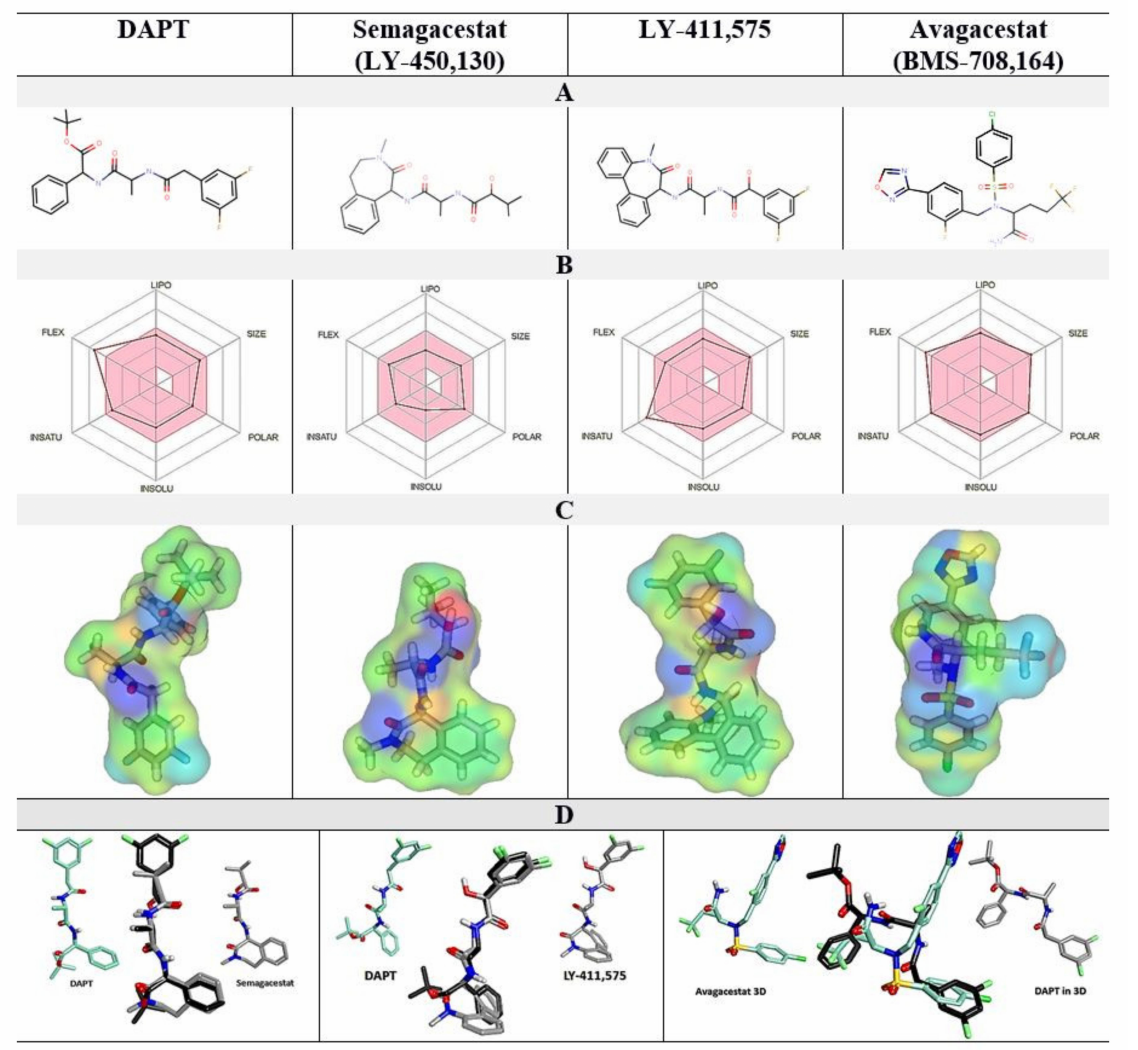
Figure 2. ( A – D ). Comparative analysis of the physicochemical properties of DAPT, semagacestat, LY-411,575, and ava- gacestat structures. ( A ) 2D structures. ( B ) A radar diagram shows the overlap with the Lipinski rules: FLEX flexibility, INSAT relative share of sp 3 carbon atoms, INSOLU LogP values, POLAR polar surface area, SIZE molecular mass, and LIPO hydrophobic surface area. The pink area represents the optimal values; the superimposed lines represent the values specific to each compound. ( C ) The electron densities are mapped on the molecular surfaces and colored to highlight the surface properties: green, hydrophobic; blue, H-bond donor; red, H-bond acceptor; yellow, polar. ( D ) The overlap between 3D molecular structures and DAPT as the reference